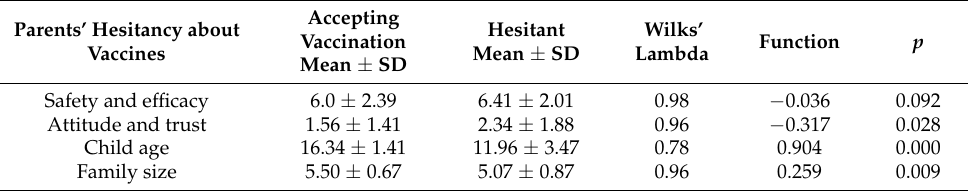
Table 5. Discriminant analysis and standardized canonical discriminant function coefficients.